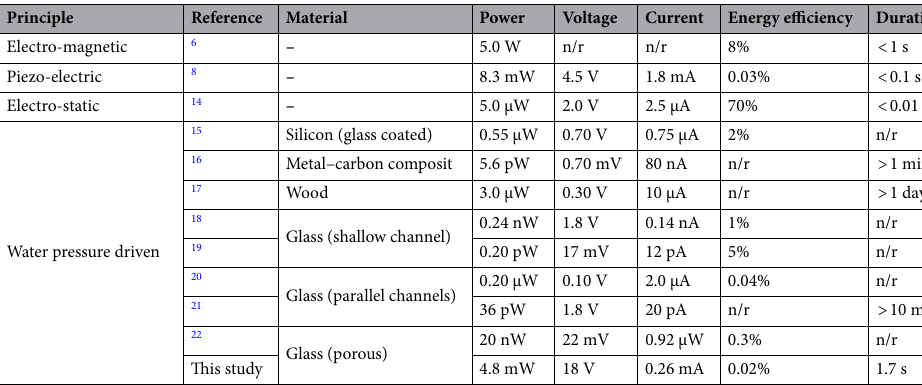
Table 1. Performance comparison of the power generation device with other mechanical energy harvesting devices regarding principle, material (only for the “water pressure driven” generation principle), structure, power, voltage, current, energy efficiency and duration (“n/r” denotes “not